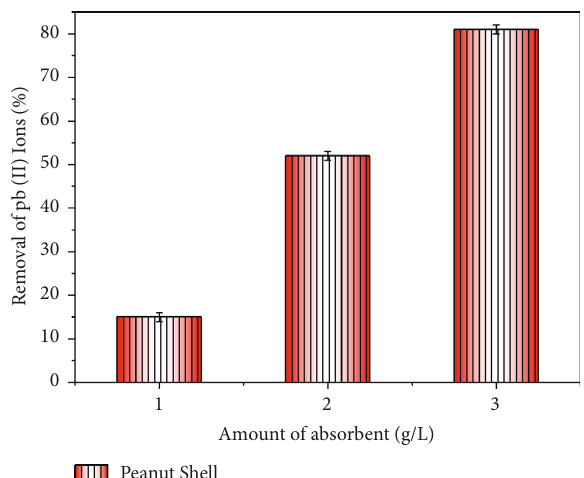
Figure 6: Influence of adsorbent dosage on Pb ions adsorption.